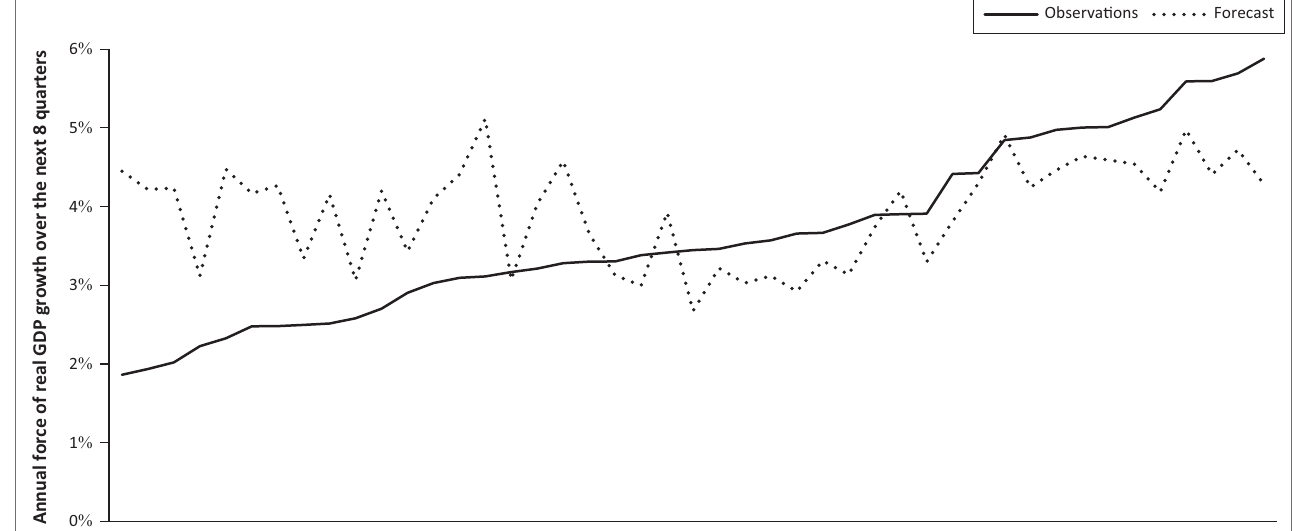
FIGURE 4: Plot of ordered observations of annual forces of real GDP growth over an eight quarter ahead period during upwards business cycles.